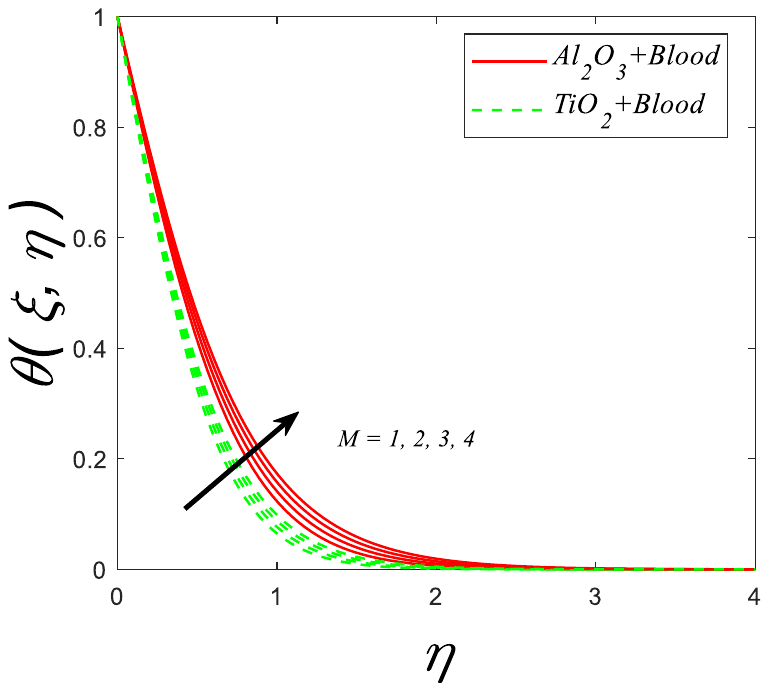
, 𝜉 = 0.1,𝑅𝑑 = 3 , ξ = 0.1, Rd = 0.1, 3